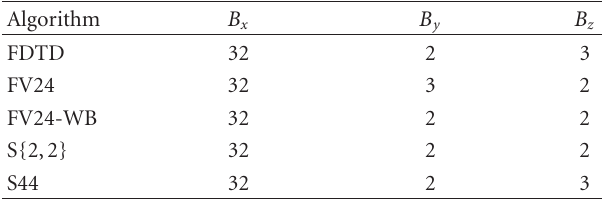
Table 3: Optimum thread-block configurations for the various FDTD algorithms.